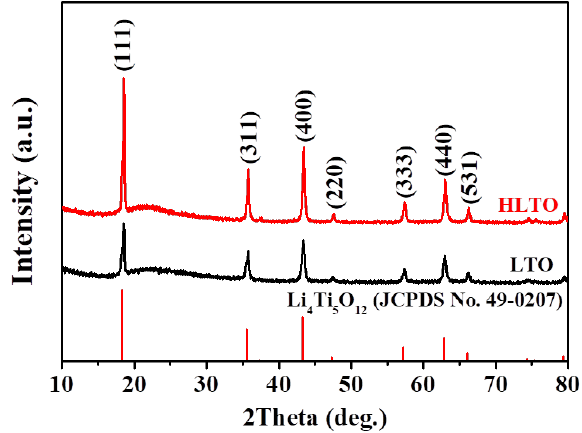
Figure 1. XRD patterns of HLTO and LTO.